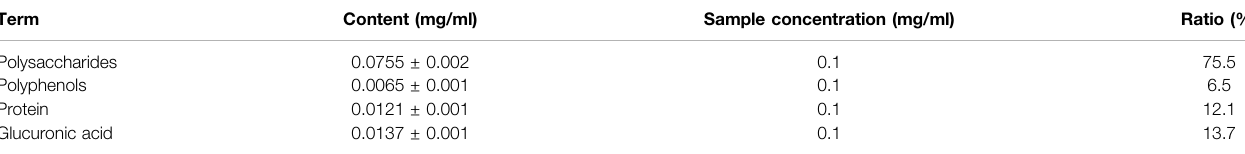
TABLE 1 | Polysaccharide, polyphenol, protein, and glycuronic contents. The data are presented as means ± SEM. Term Content (mg/ml) Sample concentration (mg/ml)